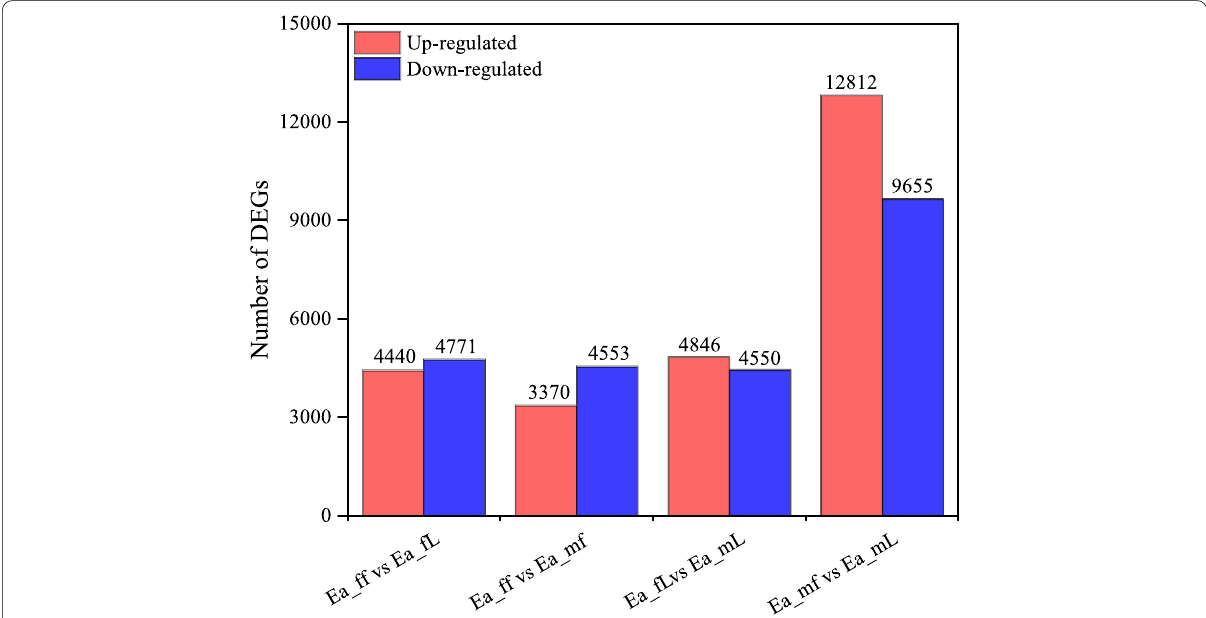
Fig. 2 Differentially expression gene (DEGs) analysis in E.